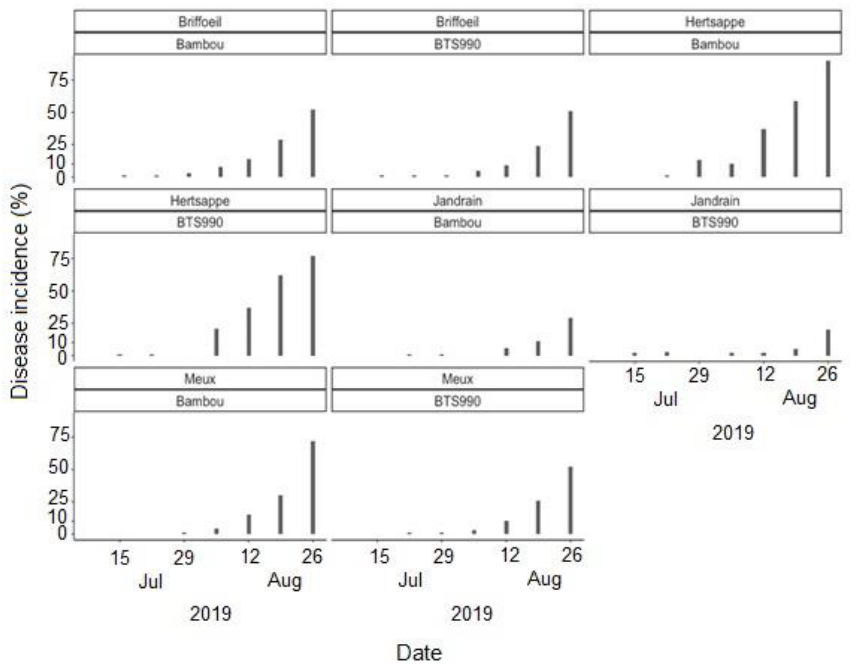
Figure 5. Observed incidence of Cercospora leaf spot at Briffoeil, Hertsappe, Jandrain, and Meux, Belgium, during the 2019 cropping season. Two different cultivars were monitored at each site.